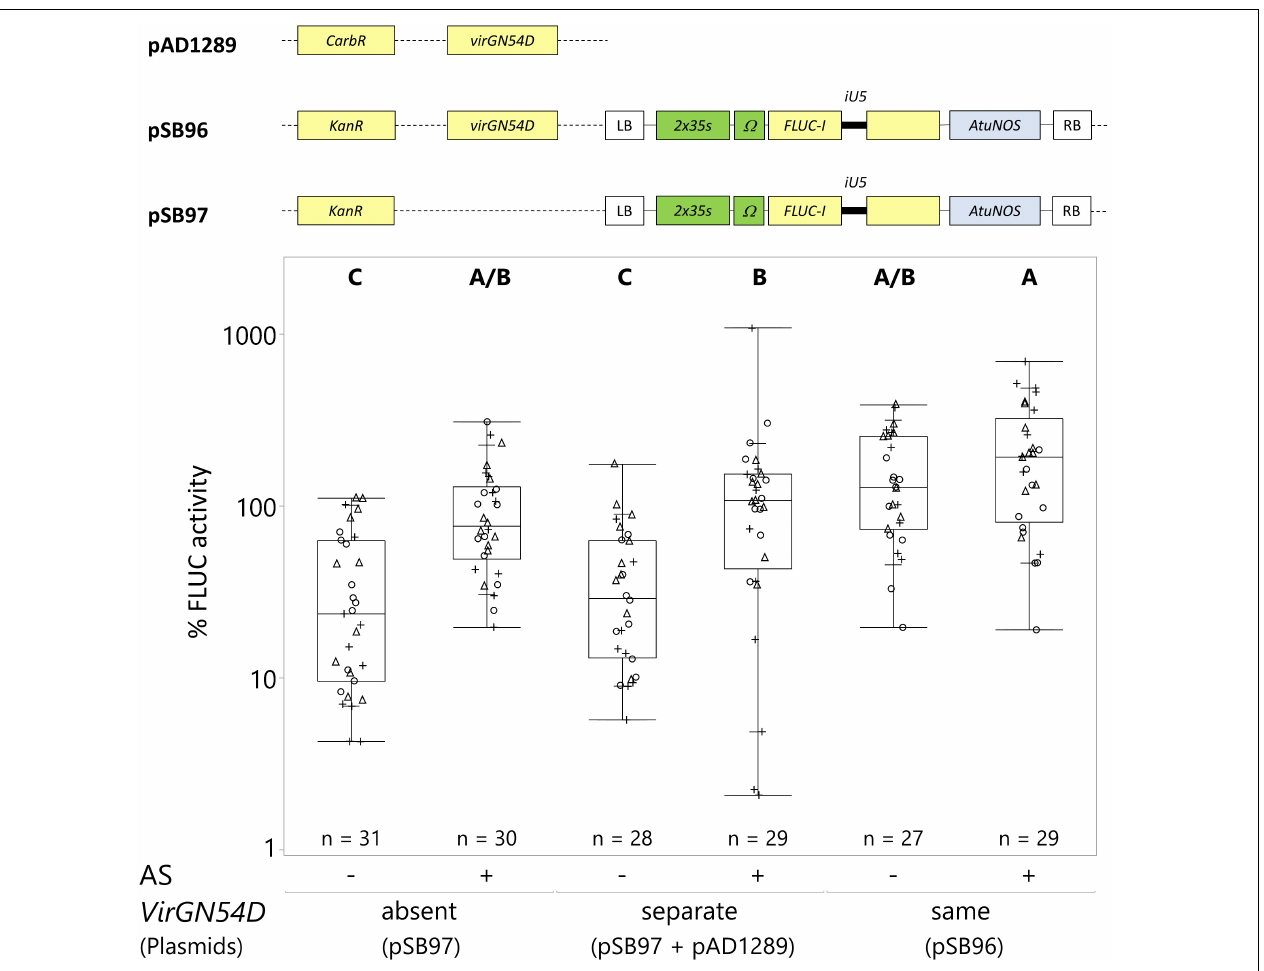
FIGURE 4 | VirGN54D and acetosyringone synergistically improve C. roseus transient transformation. C. roseus seedlings (10-days-old) were vacuum infiltrated with one strain of A. tumefaciens at OD 600 = 0.2, without (–) or with ( + ) AS. The A. tumefaciens strain contained either the reporter gene (pSB97) with no VirGN54D gene or with VirGN54D gene on a separate plasmid (pSB97 + pAD1289), or with VirGN54D on the same plasmid as the FLUC-I reporter (pSB96). Samples were taken at 3 dpi. FLUC activity was normalized to protein content. The average FLUC activity to protein content of seedlings treated with AS but in the absence of VirGN54D was used as reference (set to 100%) to determine the relative FLUC activity of each sample. The experiment was carried out in three independent assays (represented by the + , (cid:13) , (cid:49) symbols). The box plot horizontal line shows the median, ends of the boxes show interquartile range, small marks show the 10th and 90th quantile and whiskers show lowest/highest data point. Different letters indicate values that are significantly different (Tukey-Kramer HSD test on log-transformed data, p <